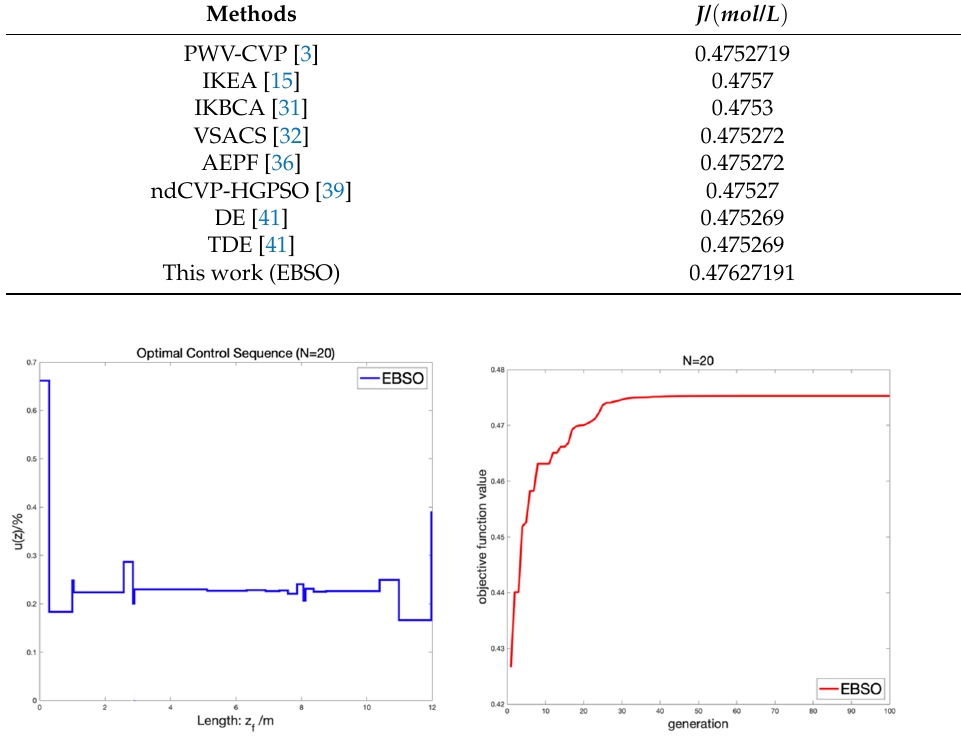
Figure 31. Optimal trajectory of state variables (